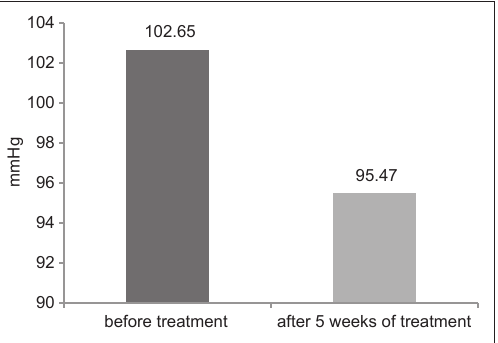
FIGURE 3. The effects of apple vinegar and syrup on blood pres‑ sure in patients with type 2 diabetes mellitus (p<0.05)